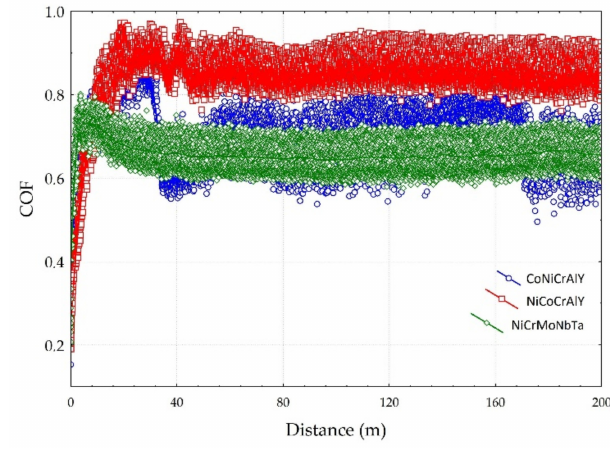
Figure 8. Coefficient of friction (COF) of the tested coatings.